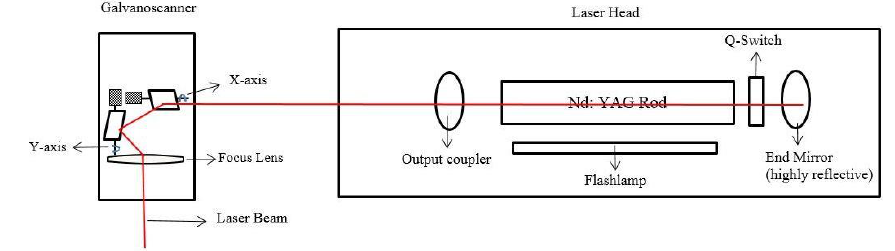
Figure 1 . Schematic diagram of Laser. Figure 1. Schematic diagram of